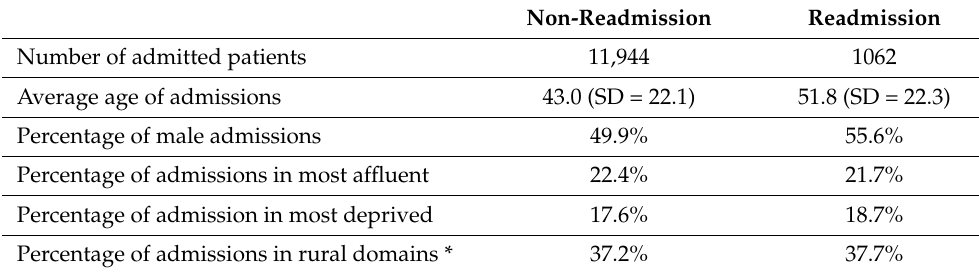
Table 1. Demographics table of campylobacter